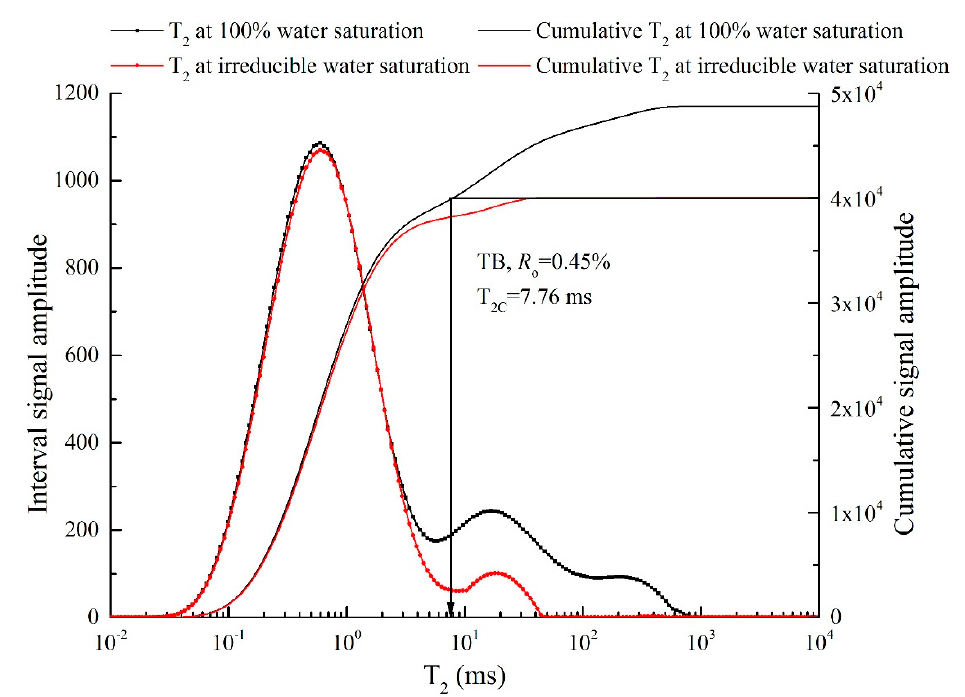
Figure 7. Nuclear Magnetic Resonance (NMR) T 2 distribution of experimental coal samples and calculation of T 2C.